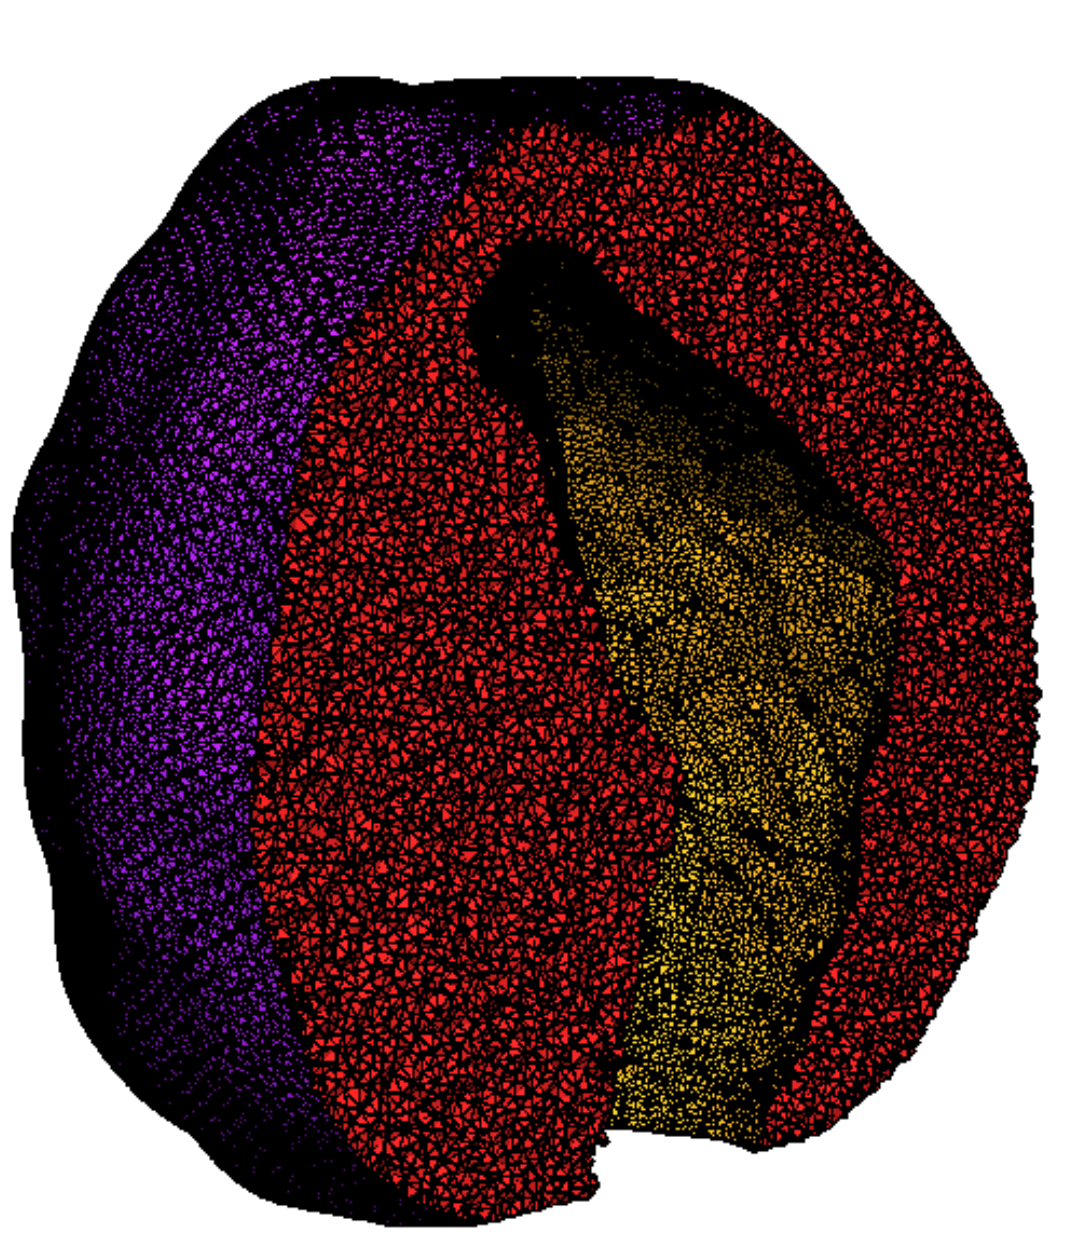
Figure 8. The real geometric model of the bouton filled by a three-dimensional mesh fitted to the two dimensional mesh shown in Figure 6. The mesh has been generated by using TetGen and it has been optimized by applying the operations such as: node smoothing, edge/face swapping, edge contraction, and vertex insertion. The artificial cut— blue , the inside of the mitochondrion— yellow , the surface of the bouton— purple . On the right—the section. The cut plane— red , the inner of the mitochondrion— yellow